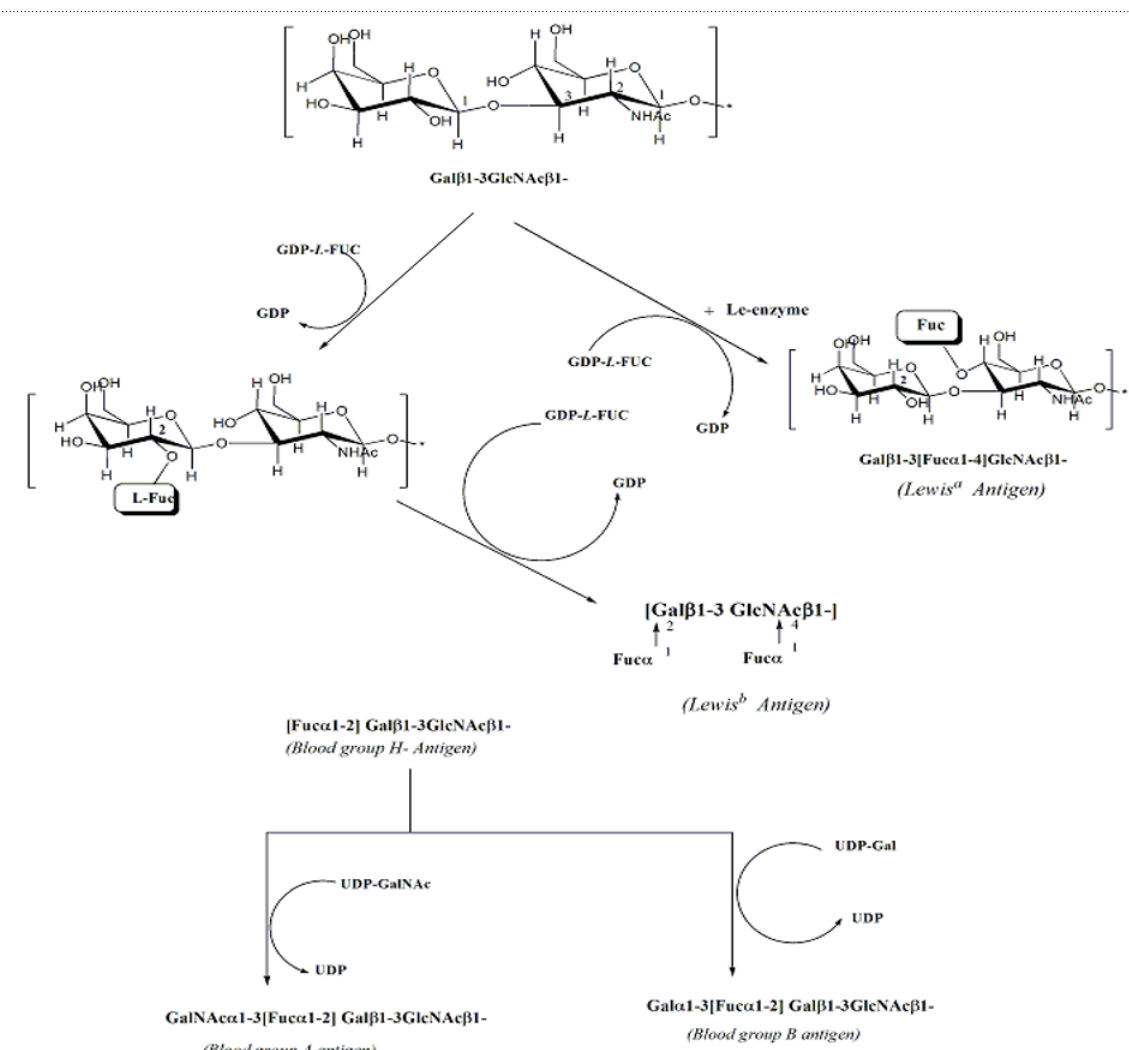
Figure 2. Glycosylation patterns of Gal β 1-3GlcNAc β 1- to form A, B, H and Lewis blood group antigens